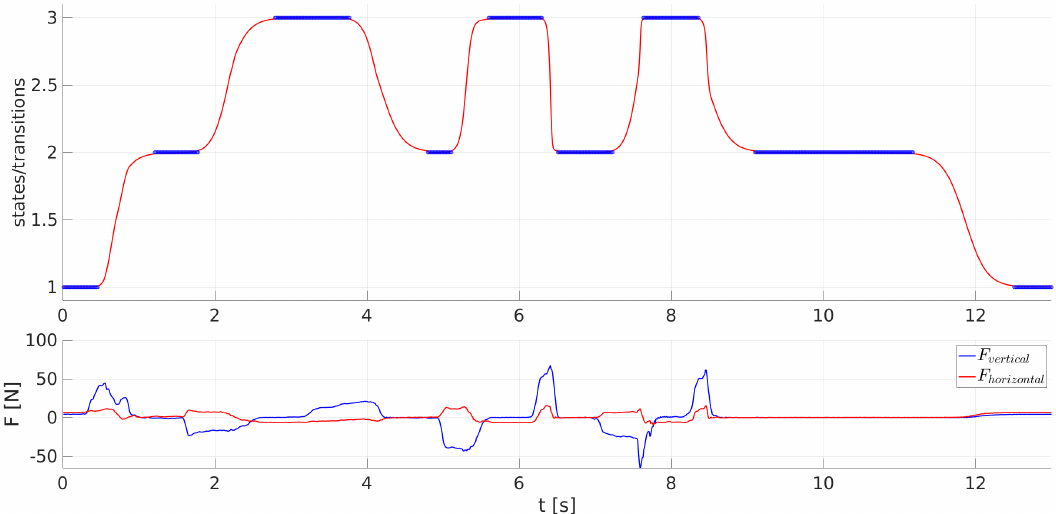
Figure 8. Transitions of the PSS between states 1–3 as a function of time with the forces exerted on the grippers of the humanoid robot.